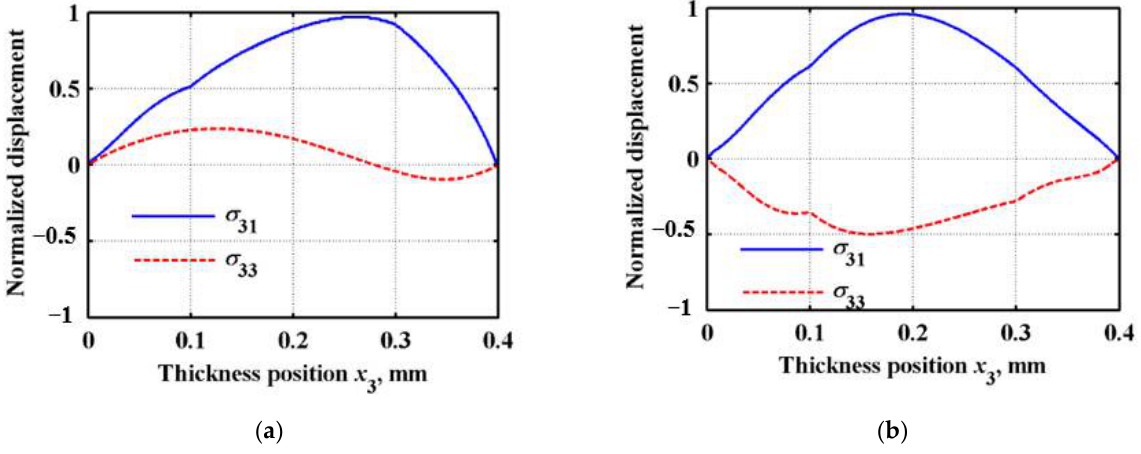
Figure 7. Lamb wave stress distribution curve in FGM sandwich plate. ( a ) A 0 mode; ( b ) S 0 mode.